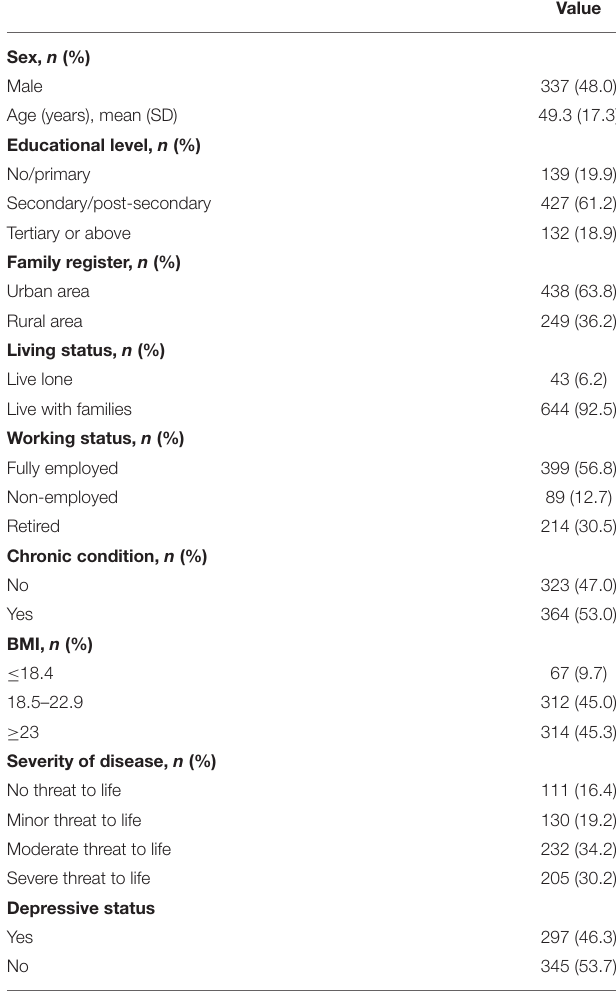
TABLE 1 | The demographics of patients ( n =